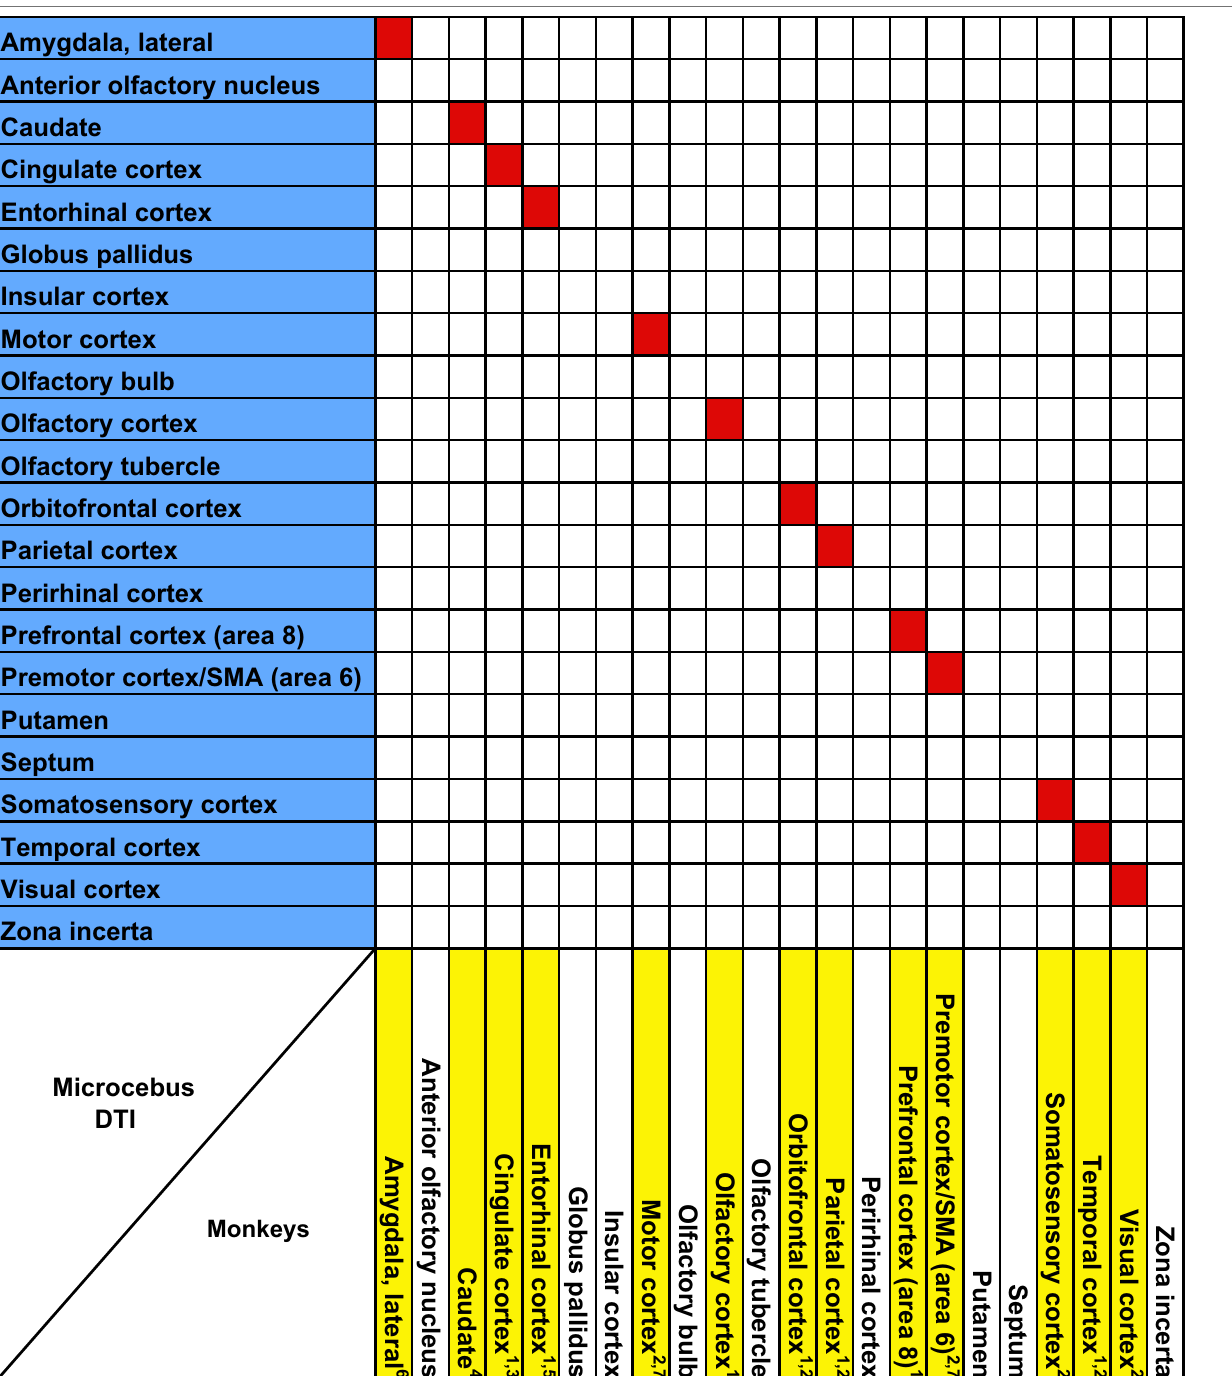
Table 2 | Comparison of claustral connectivity in the rhesus macaque ( Macaca mulatta ), the common squirrel monkey ( Saimiri sciureus ), and the Microcebus